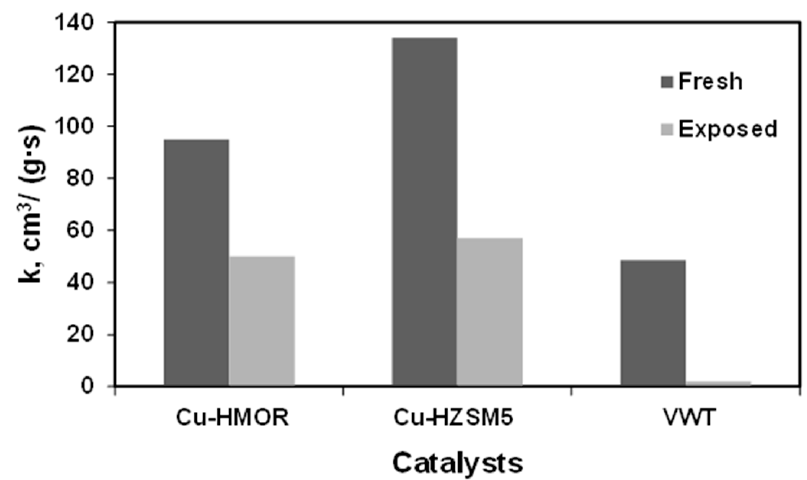
Figure 6. The SCR activity of fresh and KCl aerosol exposed Cu–HMOR, Cu-HZSM5, and VWT catalysts. Reproduced from Reference